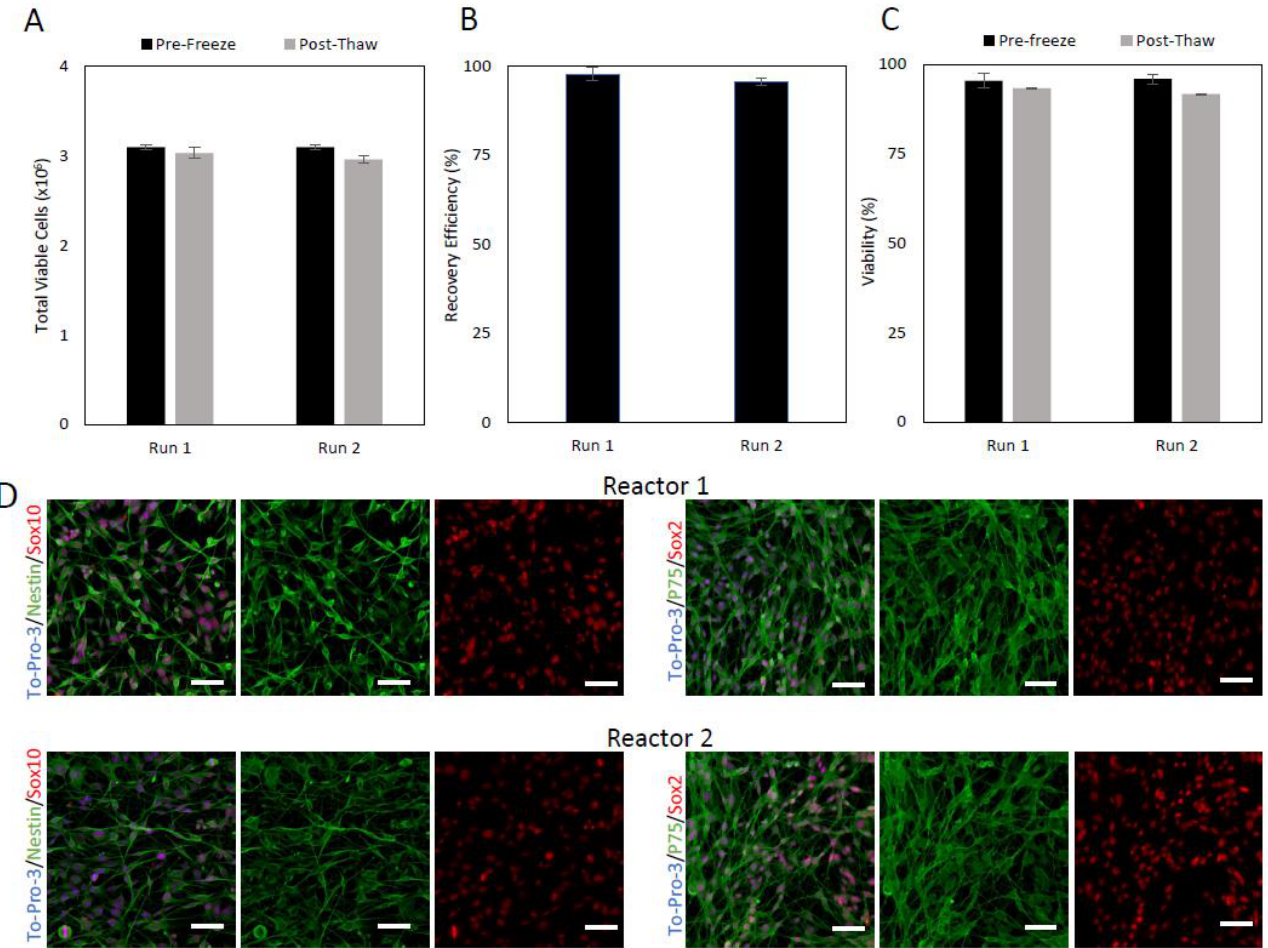
Figure 1. Total viable cell number, percent viability, and recovery efficiency of adult rat skin-derived Schwann cells (Sk-SCs), before and after cryopreservation. Sk-SCs were static expanded for 2 passages before being harvested and cryopreserved for 7 days to represent the shipping and storage involved in therapy. Following cryopreservation, cells were thawed and counted to achieve the total viable cells ( A ), the overall recovery efficiency ( B ), and the viability, before and after for cryopreservation ( C ). ( D ) Immunophenotype of pre-expansion Sk-SCs. The starting Sk-SCs were stained for expression of characteristic markers Sox10, Sox2, P75, and nestin before expansion in bioreactors. Scale bars represent 200 μm. Error bars represent one standard deviation of the mean.